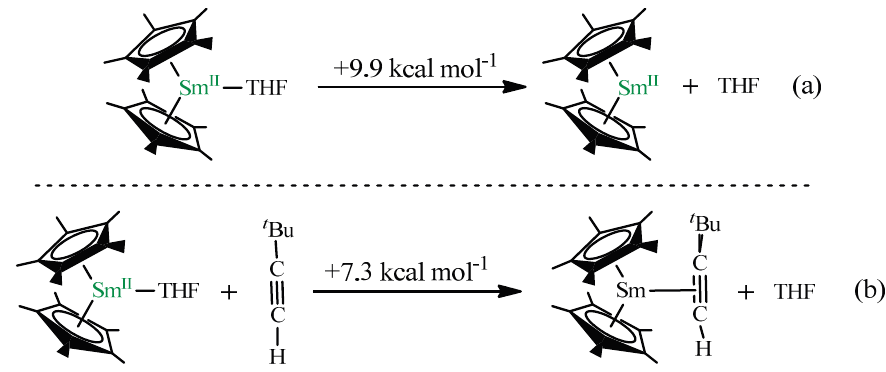
Figure 7. ( a ) Dissociation reaction of THF from the mono-solvated samarocene complex; ( b ) Exchange reaction of mono-solvated (THF) samarocene complex with t BuC ≡